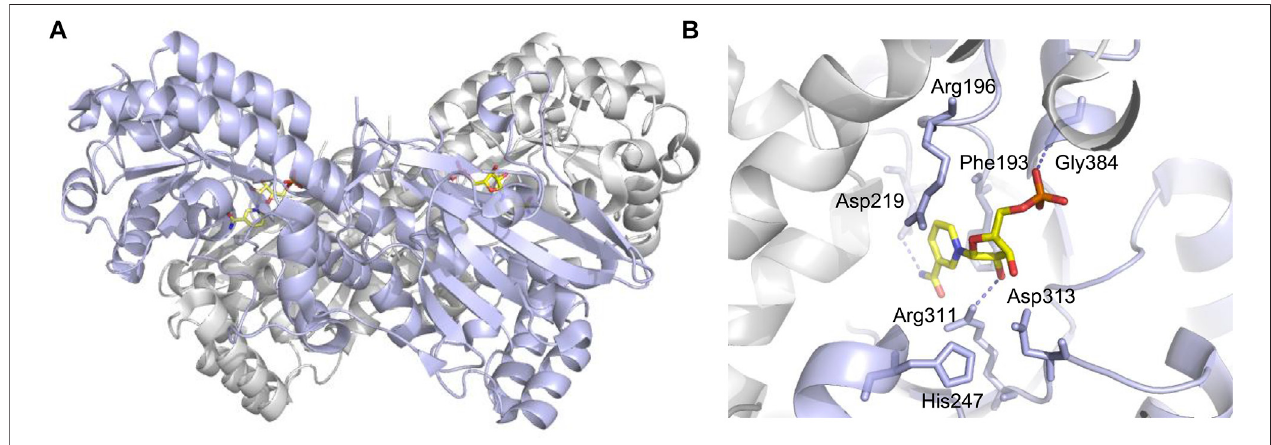
FIGURE 1 | Crucial sites for NAMPT enzymatic activity (PDB code: 2H3D). (A) One monomer is purple, the other is gray, and NMN is shown in yellow stick shape. (B) Asp219 hydrogen bonded with NAM for substrate speci fi city. His247 is used for autophosphorylation, and dotted lines indicate hydrogen bonds.